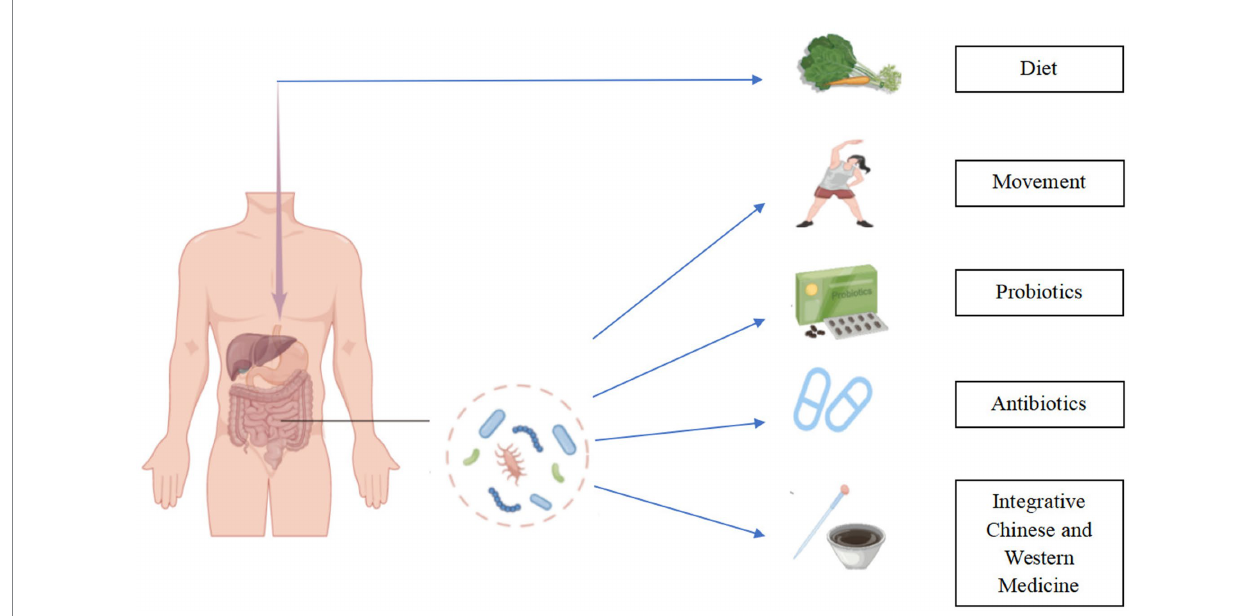
FIGURE 3 Regulating TMAO in the treatment of ischemic stroke. Modification of diet, rigorous exercise, rational use of probiotic supplements and antibiotics, and integration of traditional Chinese and Western medicine can reduce the burden of ischemic stroke by reducing TMAO